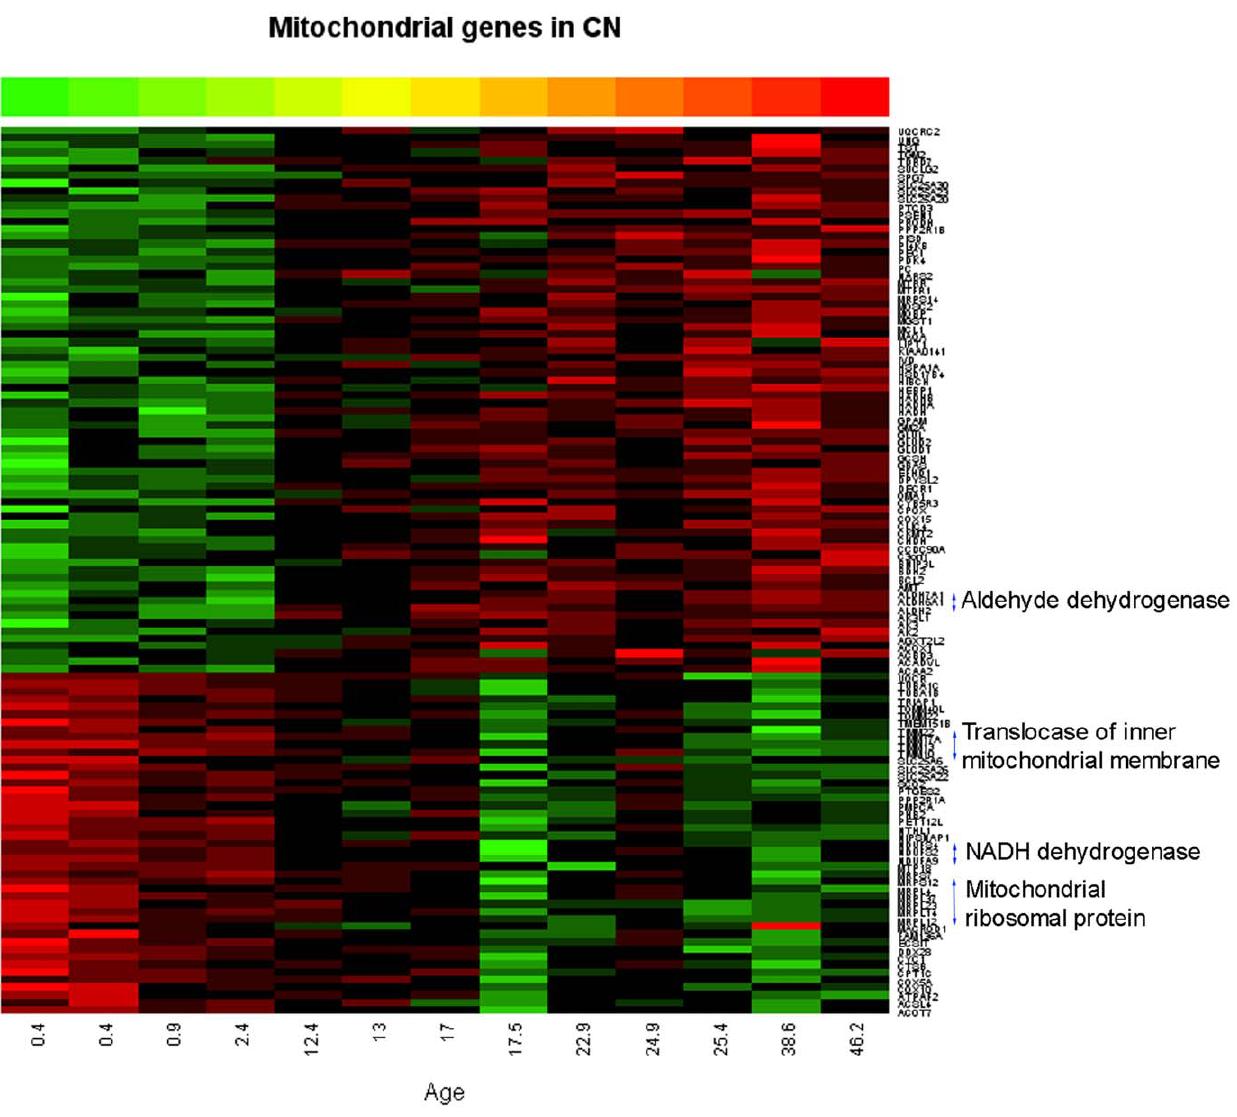
Figure 2. Developmental expression pattern of the genes associated with mitochondrial function in the CN. Approximately 62% of the genes (72/117) show increasing expression (green to red), while 38% of the genes (45/117) show decreasing expression (red to green) during development. X-axis: Age (years). Y-axis: Gene symbols. Genes that encode different subunits of the same protein are shown on the right side. On the contrary to the PFC, very few genes encode different subunits of the same protein. Color bar scale: hybridization intensity (log base 2) from 4.45 to 13.56.